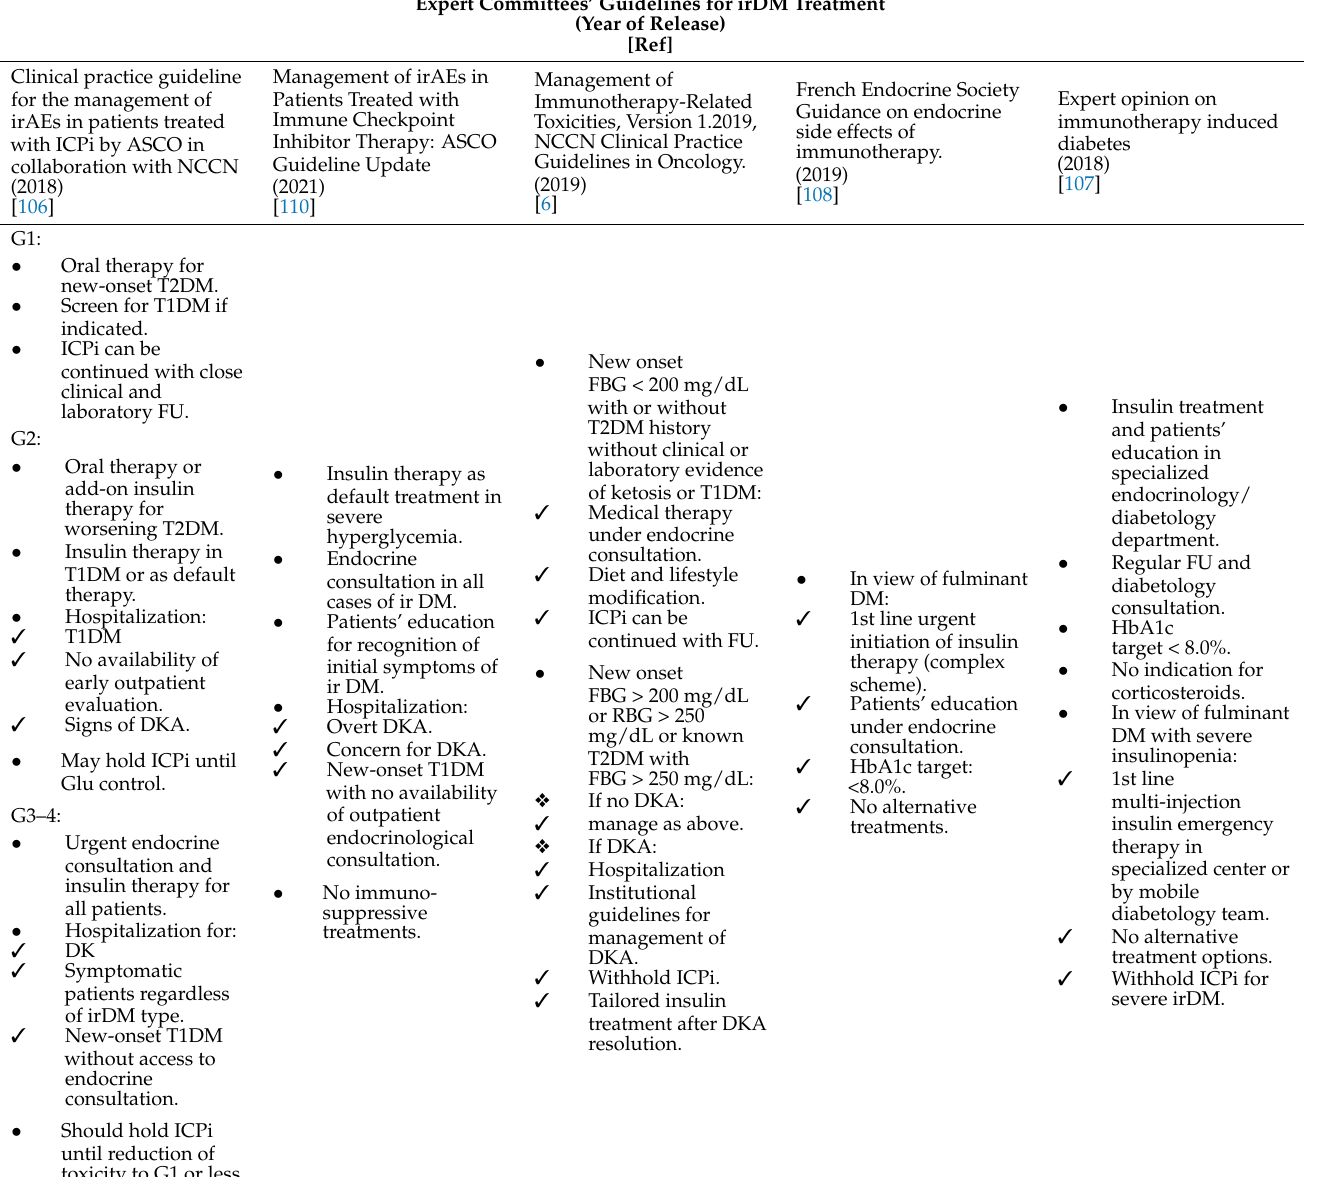
Table 4. The main guidelines for irDM treatment by expert committees. Expert Committees’ Guidelines for irDM Treatment (Year of